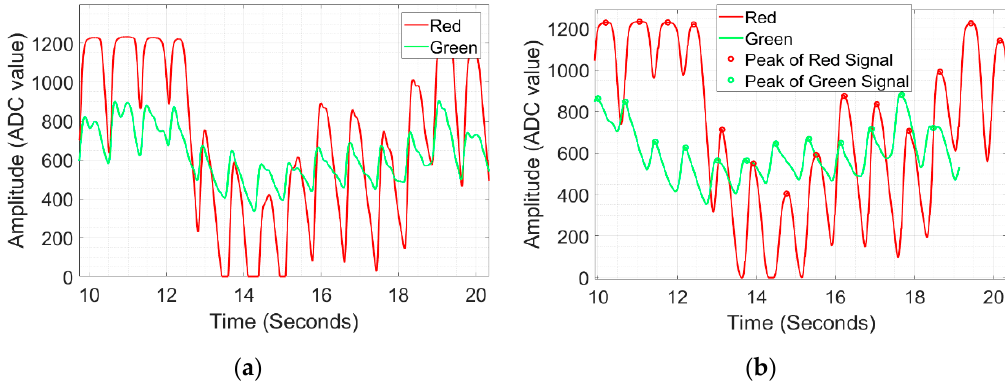
Figure 24. ( a ) Output of red and green PPG signals with the left ‐ right finger motion, ( b ) peak detection of the PPG signals.